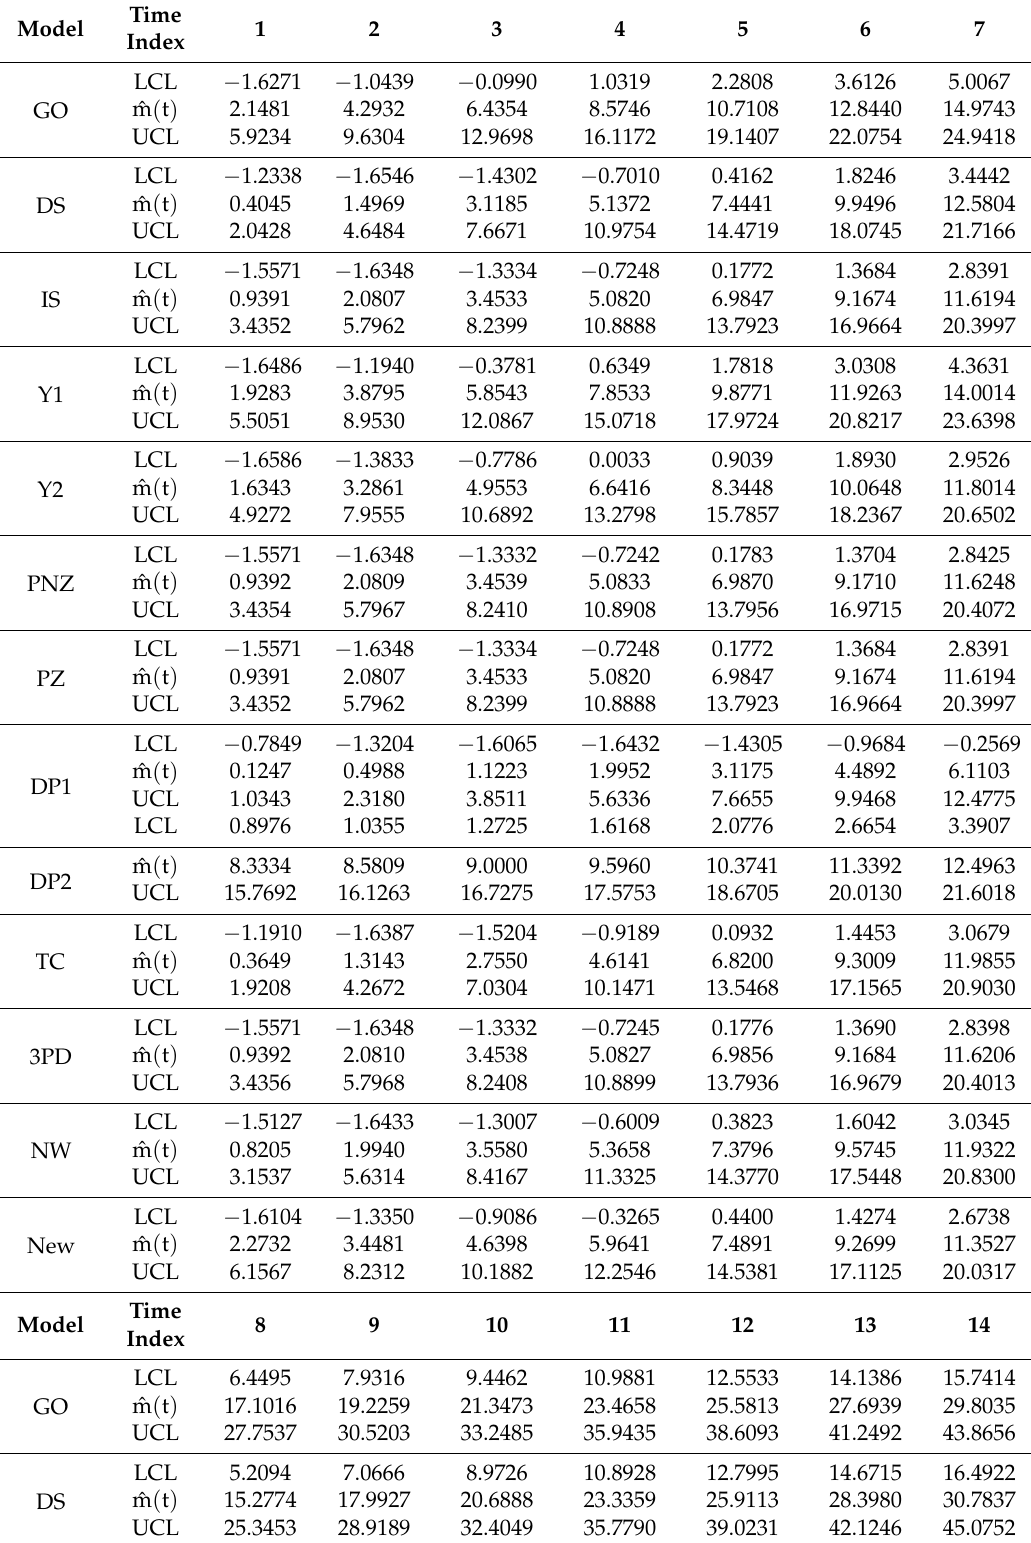
Table A3. 99% Confidence interval of all 13 SRM models from Dataset